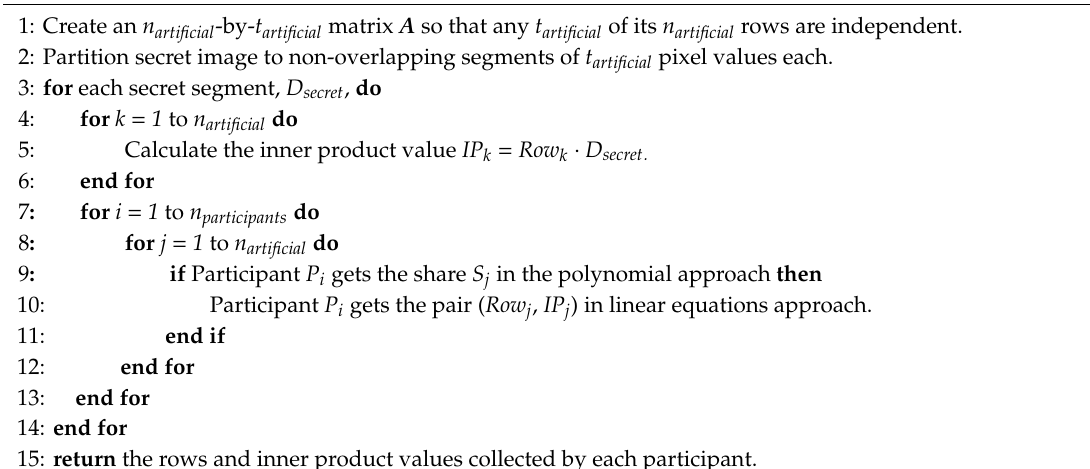
Algorithm 2. General procedure to derive the linear-equations approach from the ( t artificial , n artificial ) polynomial